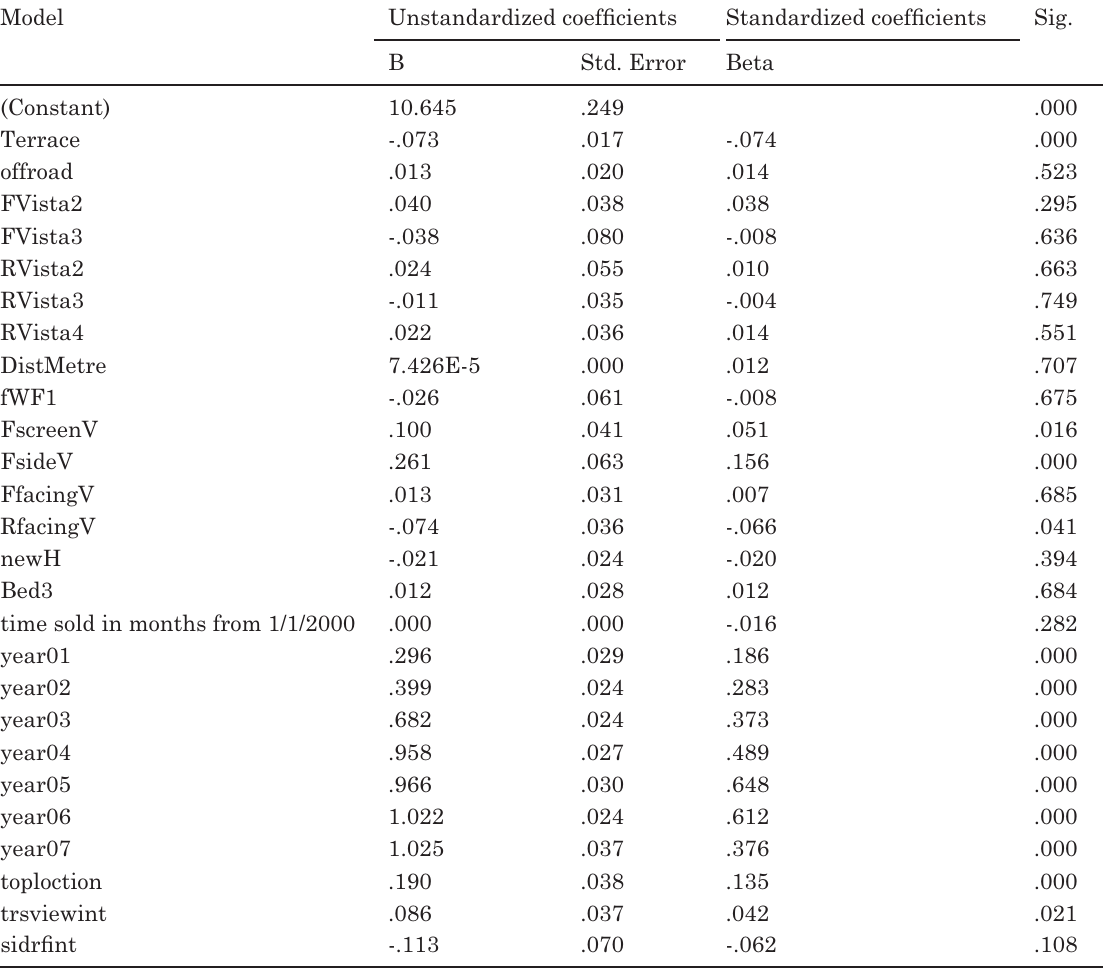
Table 6. Regression coeffi cients for model including independent variables and interactions